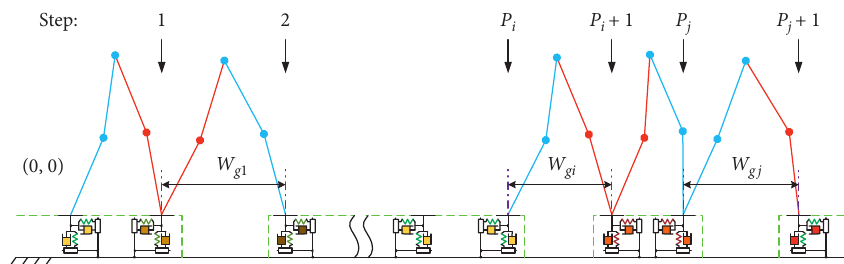
Figure 2: Models of the rigid robot and the compliant ground